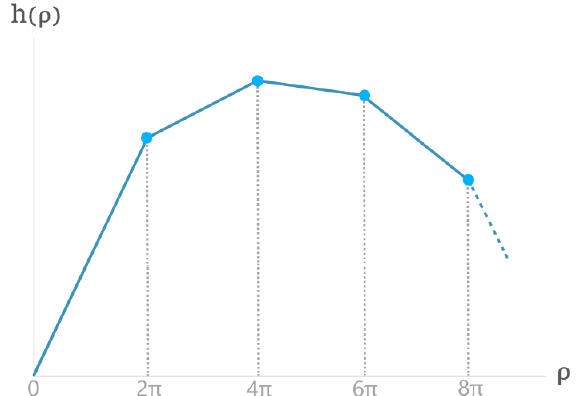
Figure 1 . An example of a linear function h 4 ; 8 ( (cid:26) ). This kind of function is de(cid:12)ned piecewise on every interval (cid:26) 2 [2 (cid:25)k; 2( k + 1) (cid:25) ], while it decreases in slope along the (cid:26)